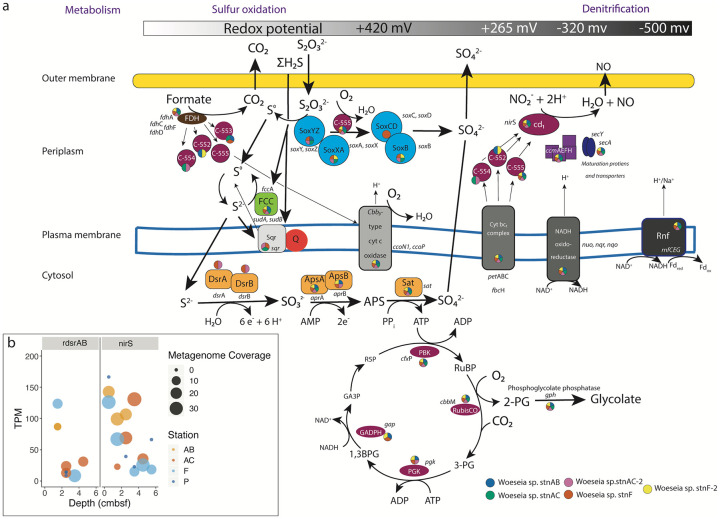
Sulfur oxidation and denitrification in Woeseiales MAGs.Schematic representation of metabolic pathways reconstructed in Woeseiales MAGs (a). The gray/black bar at the top corresponds to the redox potential for the key cytochromes depicted in the figure (sulfide quinone reductase, cbb3-type c oxidase, cyt bc1 complex, NADPH oxidoreductase, and the Rnf complex). Colors in circles next to each protein represent the presence in the MAGs. Depth trends in transcriptional coverage (reported in TPM) for nirS and the alpha and/or beta subunits of dsr are reported (b).